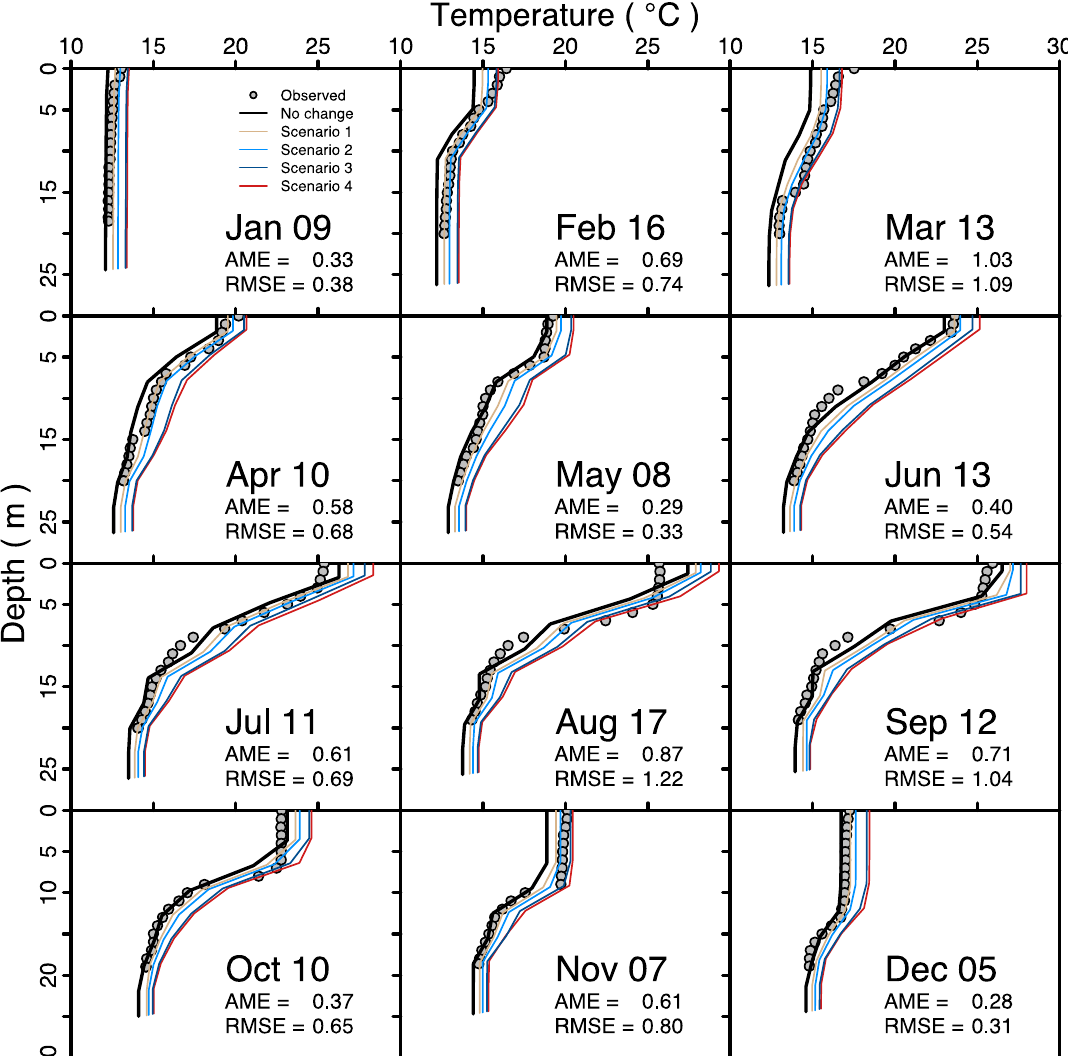
Figure 4. Observed and modeled temperature profiles in 1995, a typical year with seasonal stratification. There are five simulated profiles: one under historical climate conditions (No change) and four increased air temperature scenarios (Scenario 1 to 4; Table 1).